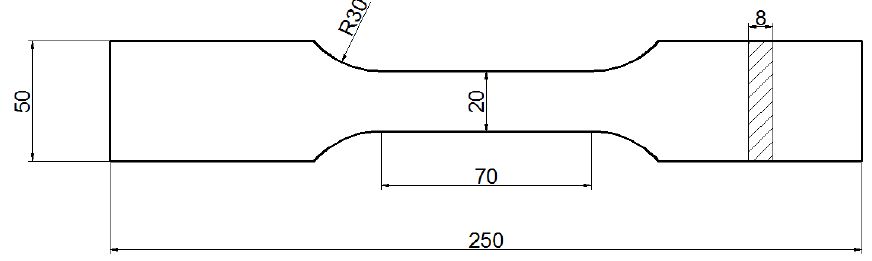
Figure 3. Geometry and dimension of smooth fatigue specimen.